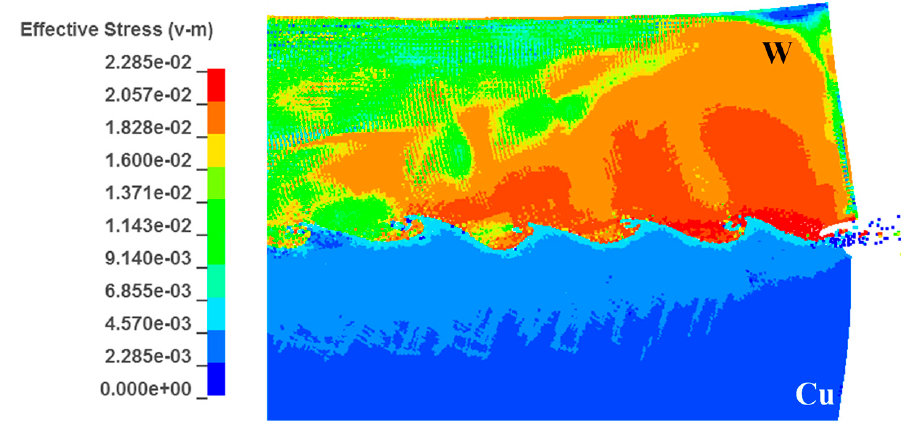
Figure 14. Distribution of equivalent stress at the W/Cu interface.